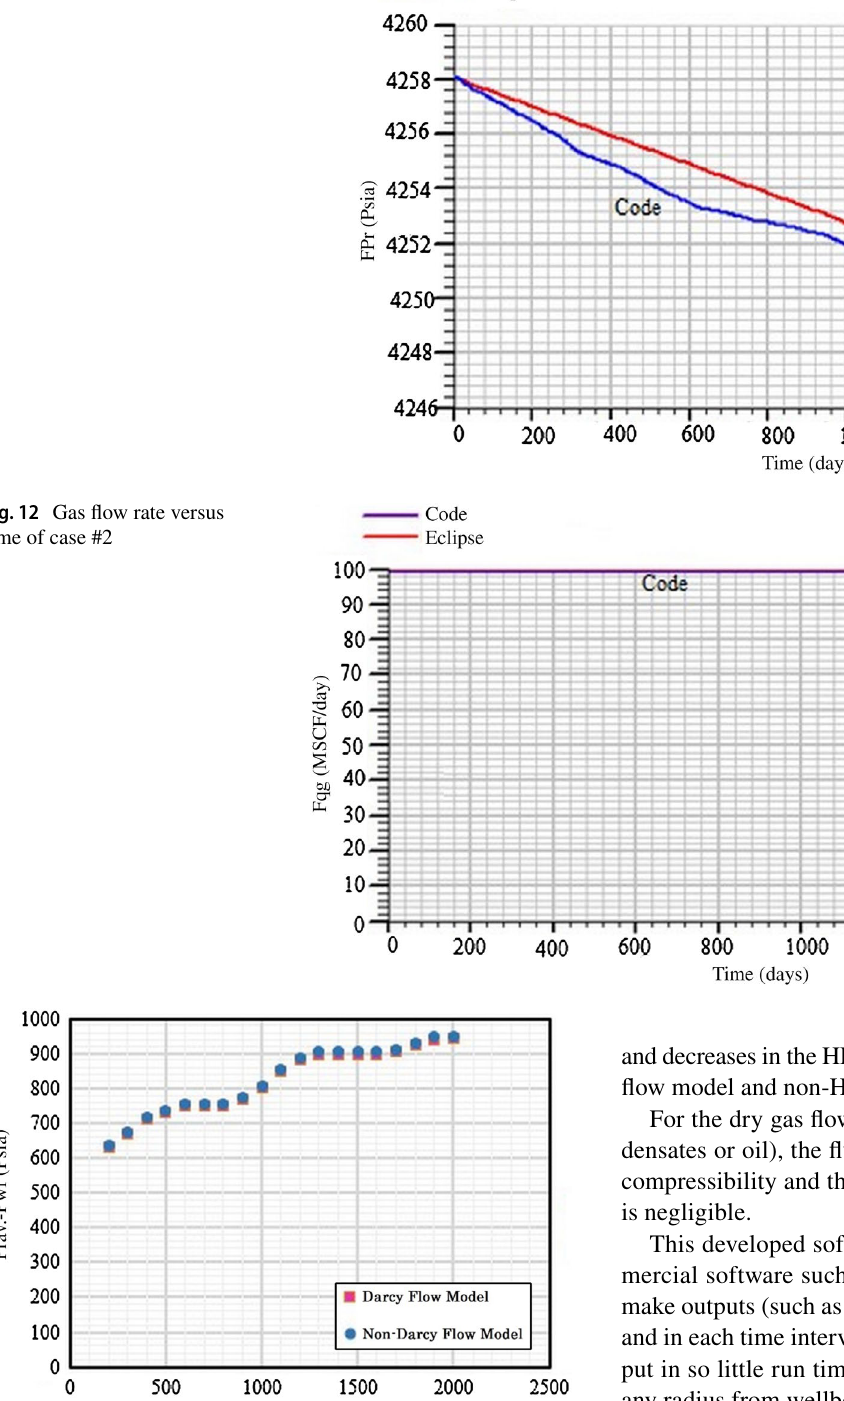
Fig. 11 Average reservoir pres- sure versus time of case #2